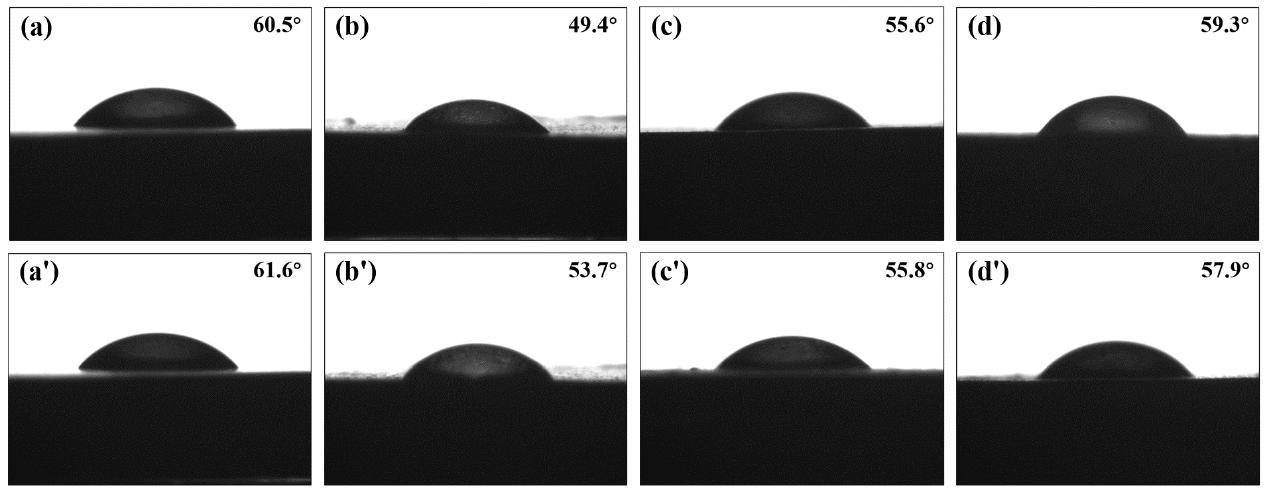
Figure 5. Contact angles of ( a , a’ ) PMMA substrate, DLC films deposited on Ti/PMMA with conduc- tive material at the different bias of ( b , b’ ) 550 V, ( c , c’ ) 750 V, and ( d , d’ ) 950 V. ( a – d ) represents the contact angle of the corresponding sample center, while ( a’ – d’ ) represents the contact angle of the corresponding sample edge. corresponding sample